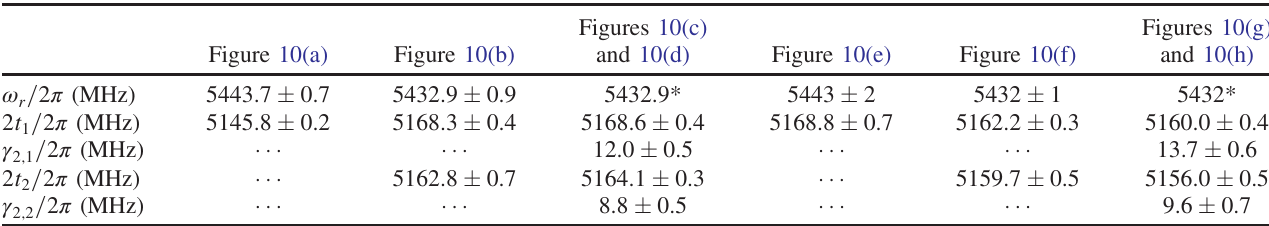
TABLE VI. Extracted values from the Hamiltonian [Figs. 10(a), 10(b), 10(e), and 10(f)] and master-equation fits [Figs. 10(c), 10(d), 10(g), and 10(h)]. Parameters that remain fixed are indicated by *.